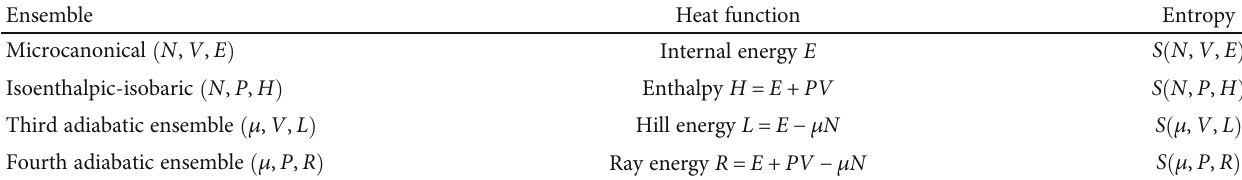
Table 1: Adiabatic